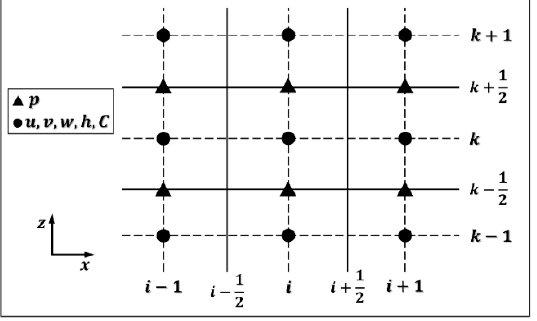
Figure 2. Keller-Box layout of computational variables. Velocities ( u , v , w ), water depth ( h ), and passive tracer scaler ( C ) are all placed at cell center and dynamic pressure ( p ) is placed at vertical cell face. In the advection and diffusion equations, the convective fluxes are determined using the hybrid linear/parabolic approximation (HLPA) scheme [34], which is a low-diffusive and oscillation-free convection scheme and has an approximately second-order accuracy in space. The solution procedure is illustrated in Figure